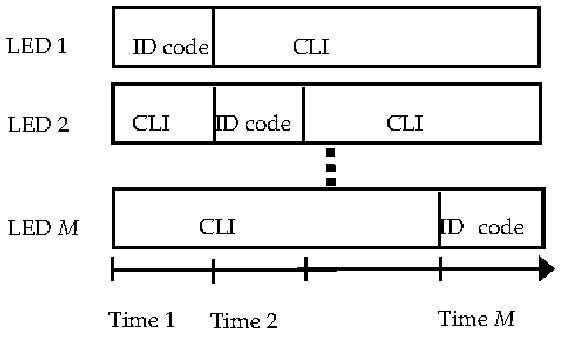
Figure 2. Frame structure of the positioning system for one period.